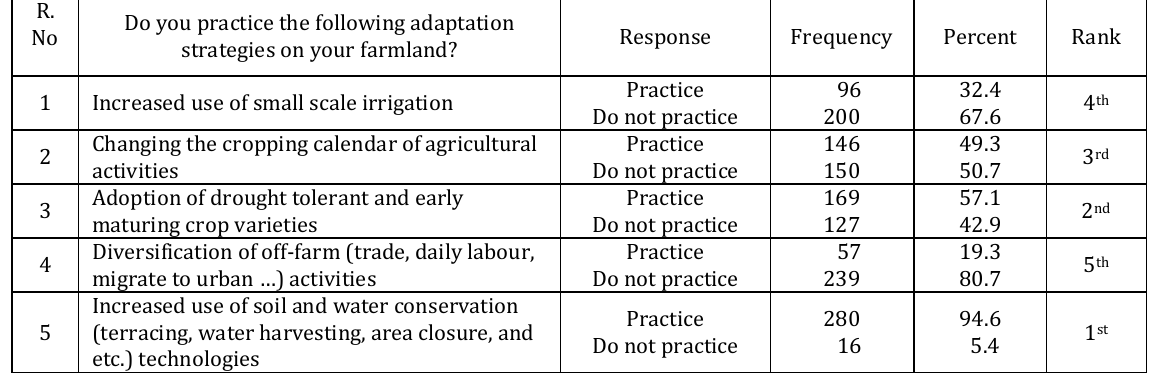
Table 9. Practice of climate change adaptation strategies (Source: Survey, April 2018) R.